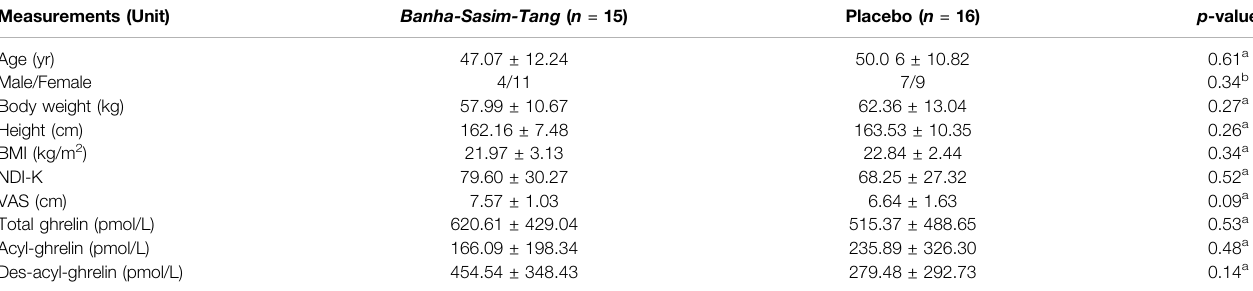
TABLE 3 | Baseline characteristics of